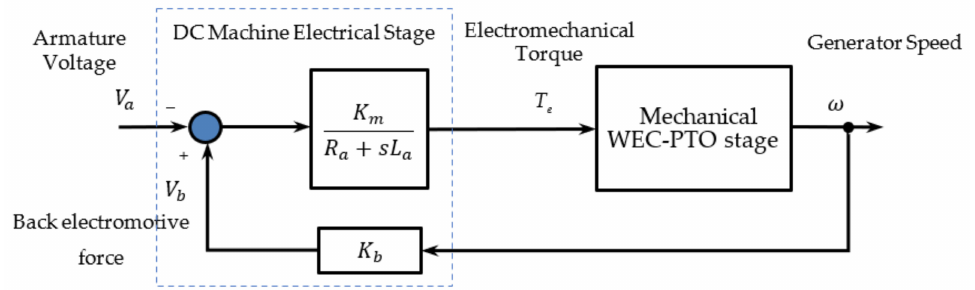
Figure 3. Armature-controlled DC generator block diagram, motion-actuated by a